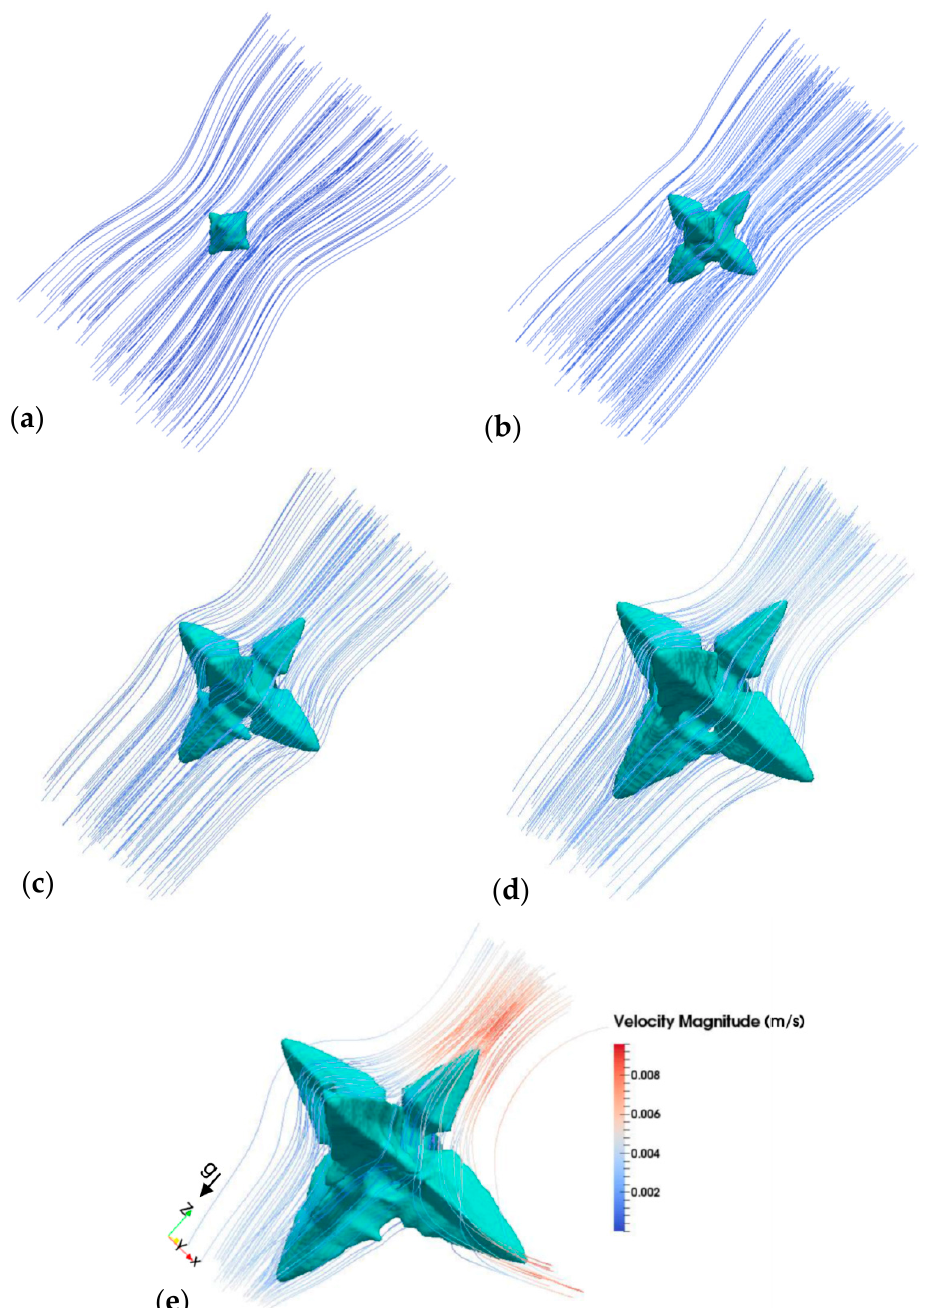
Figure 16. Evolution of dendritic structures under natural convection after ( a ) 1.2 ms, ( b ) 2.4 ms, ( c ) 3.6 ms, ( d ) 4.8 ms, and ( e ) 6 ms.